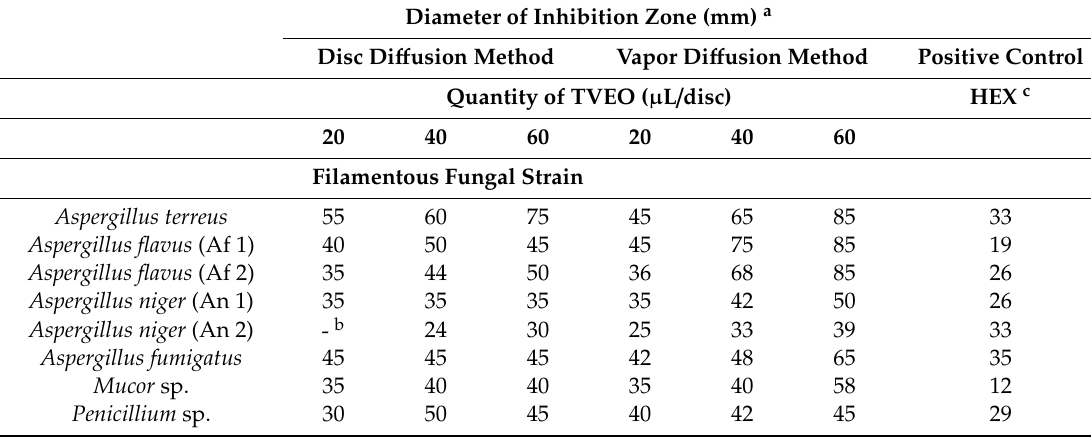
Table 3. Susceptibility of filamentous fungal strains to Thymus vulgaris essential